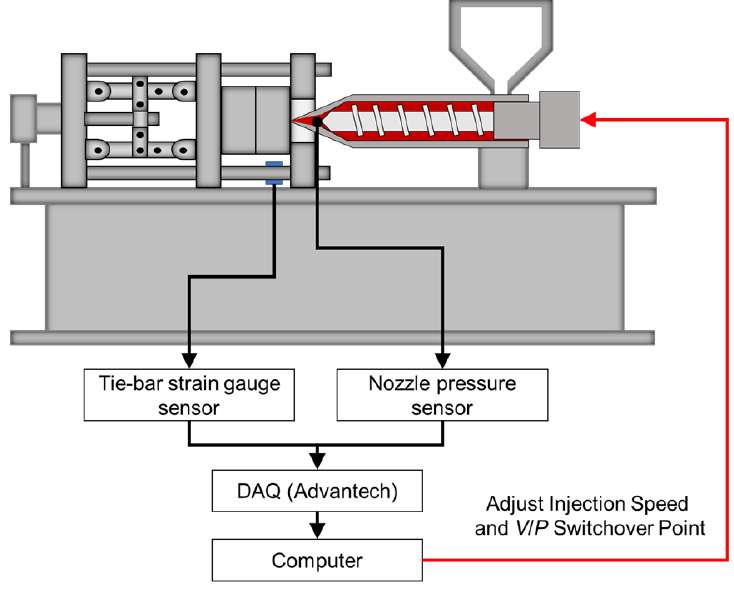
Figure 23. Adaptive process control system.